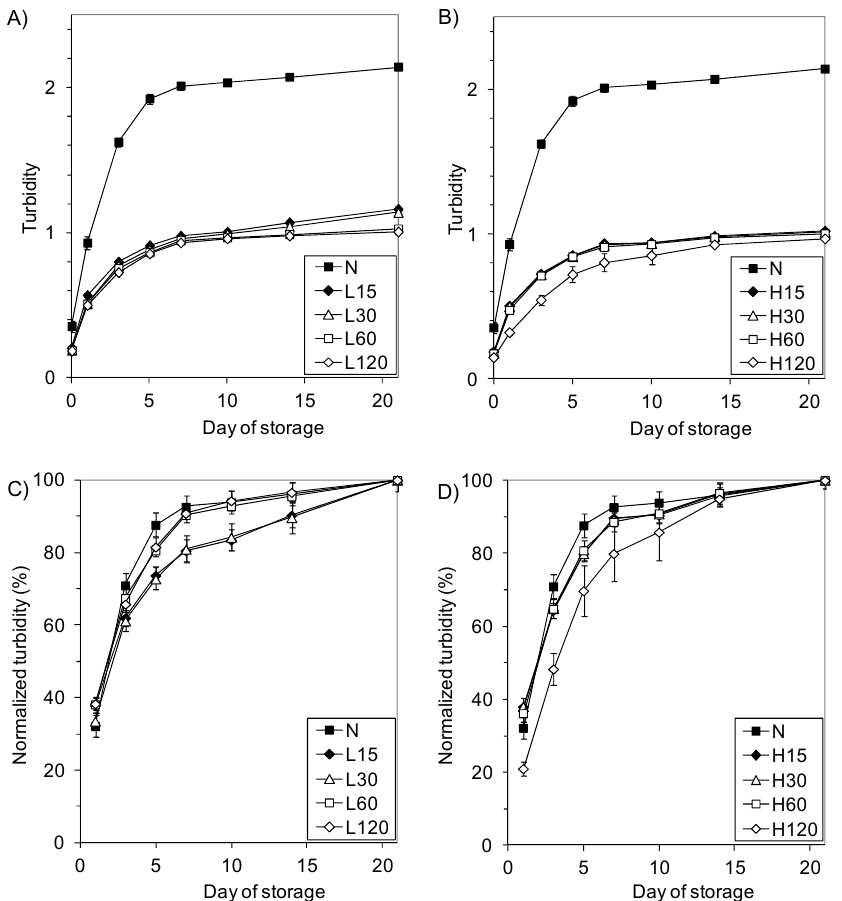
Figure 4. Time dependence of turbidity of 2% pastes stored at 8 °C: ( A ) turbidity of L-starches, ( B ) turbidity of H-starches, ( C ) normalized turbidity of L-starches, ( D ) normalized turbidity of H-starches.